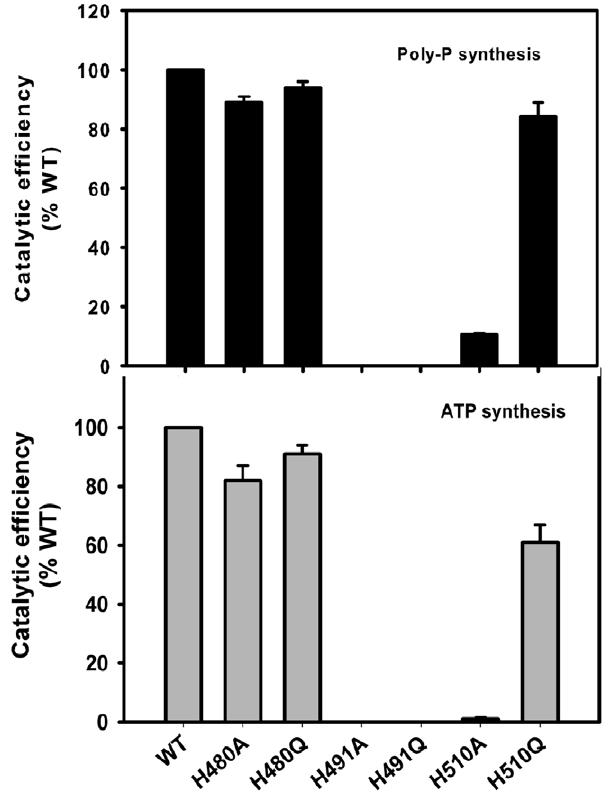
Figure 2. His-510 influences ATP synthesis ability of mPPK1. Effect of conserved His residue mutations on the kinetic efficiencies for poly-P synthesis and its mobilization (ATP synthesis) by mPPK1 was assessed (please see Tables 1 and 2). Kinetic efficiencies ( k cat / K m ) for poly-P and ATP syntheses were determined from each experiment and expressed as % wild-type control (100% poly-P synthesis =34.7 6 1.3 mM 2 1 s 2 1 , while that of ATP synthesis =5743 6 646 mM 2 1 s 2 1 ).